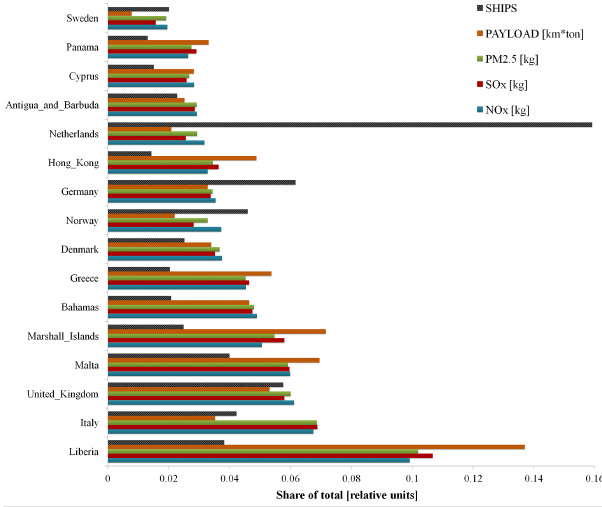
Figure 5. Relative contributions of various flag states to selected emissions, the numbers of ships and cargo payload in Europe in 2011. We have selected 20 states that had the highest emissions of CO 2 . These states have been presented in terms of the emissions of CO 2 ; the lowest entry (Liberia) in the figure had the highest emis- sions.